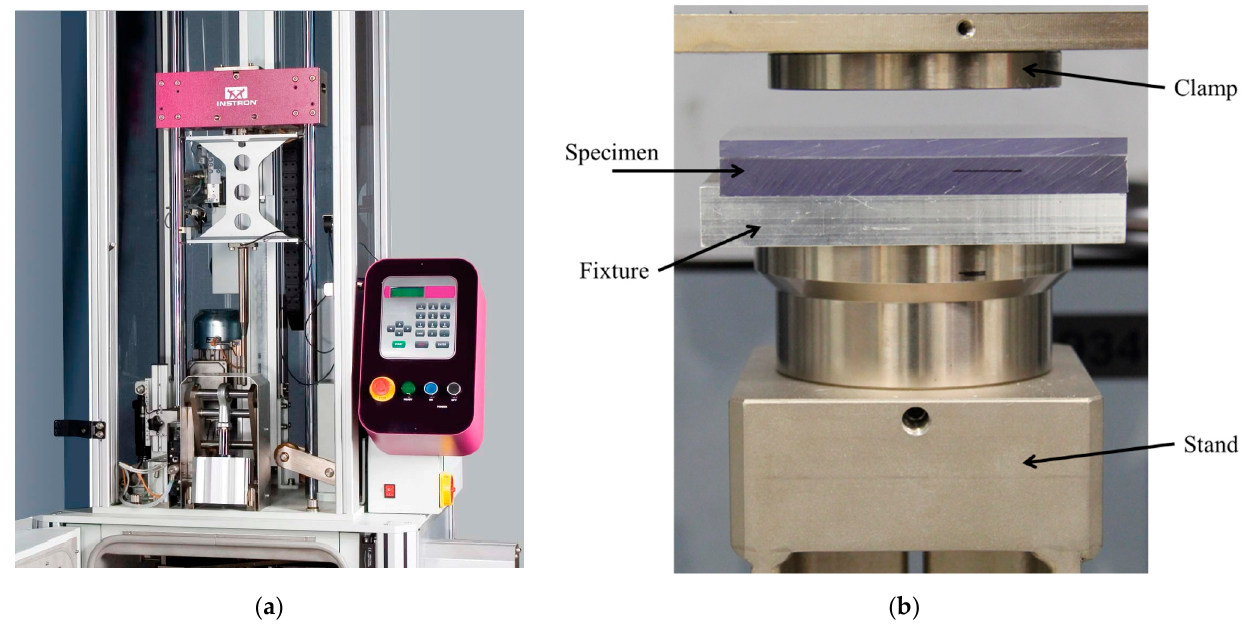
Figure 4. ( a ) A drop-weight impact test machine; ( b ) a loaded specimen at the test